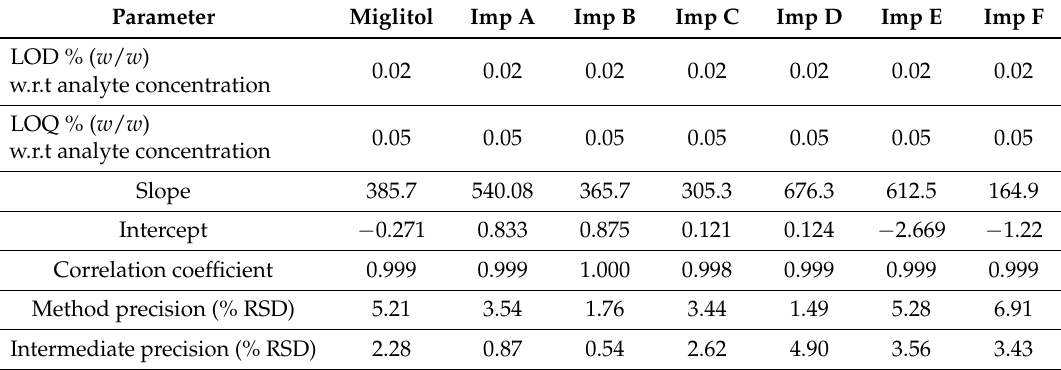
W.r.t: with respect to RSD: relative standard deviation. Table 2. Chemical name, structure and decoding list of miglitol and impurities.